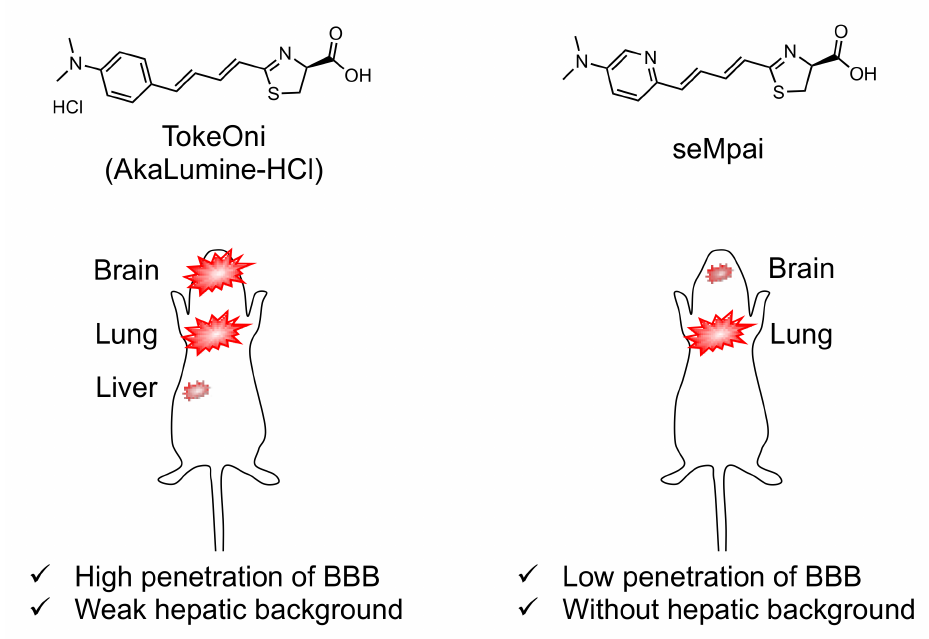
Figure 2. The different bioluminescence imaging (BLI) activities of TokeOni and seMpai and their structures. TokeOni enables high-resolution imaging of brain and lung tissues at the single-cell level but presents hepatic background signals, which is caused by its hydrophobicity; however, seMpai enables high-resolution BLI without hepatic background signals, but its hydrophilicity interferes its penetration of the blood–brain barrier